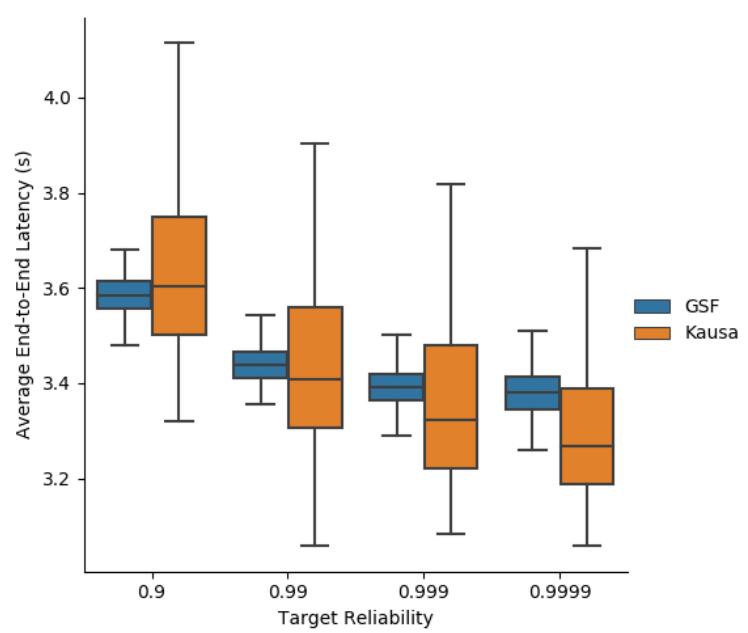
Figure 16. Average end-to-end latency obtained with MOpt and Kausa .